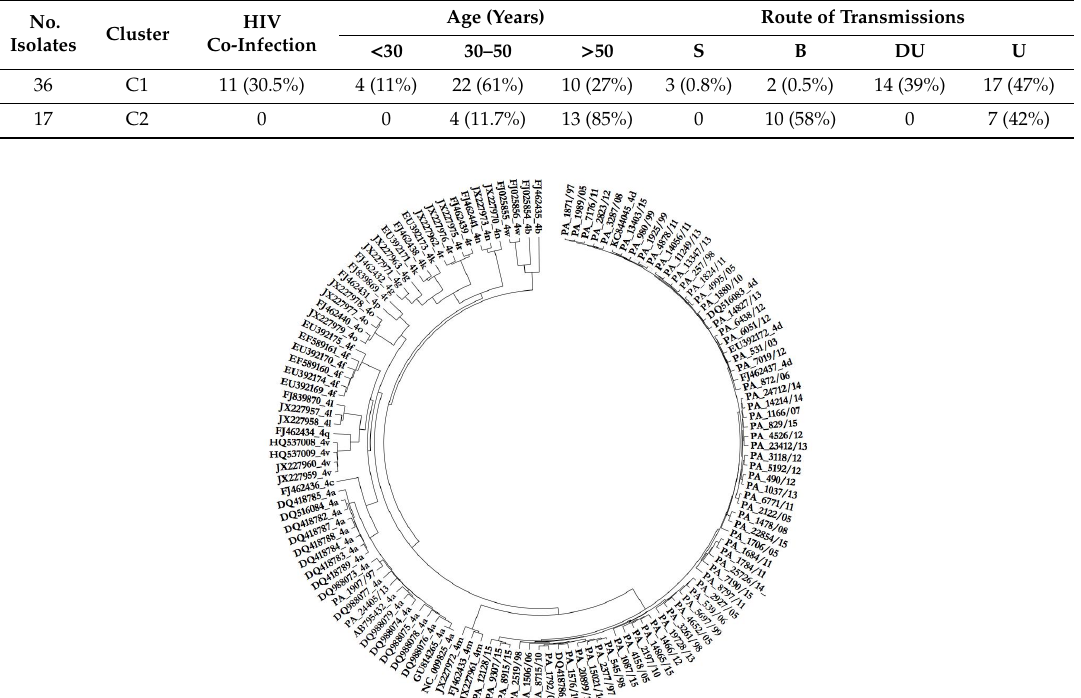
Figure 1. Phylogenetic tree of the NS3 region (450 bp) made with T93+G+I (bootstrap 1000 replicates)